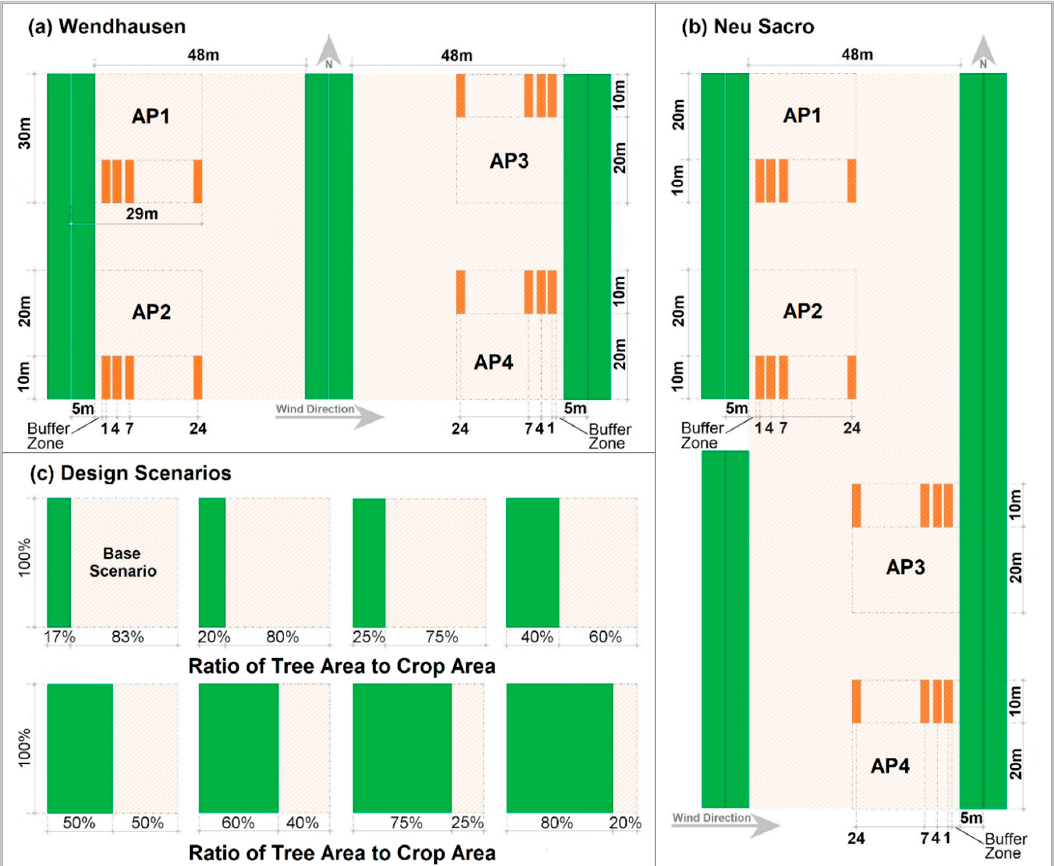
Figure A2. To-scale sketch of the 29 m × 30 m alley-cropping-plots (APs) design at Wendhausen ( a ) and Neu Sacro ( b ). At both sites, AP1 and AP2 are arranged leeward and AP3 and AP4 windward. The solid-coloured areas correspond to the tree strips and the shaded areas to the cropped surfaces. The orange bars represent the 2 m × 10 harvest transects located 1 m, 4 m, 7 m, and 24 m away from the tree strips. As the experimental part of this study focused on a ratio of tree area to crop area of 17:82, the simulations considered design scenarios with ratios of tree area to crop area of 20:80, 25:75, 40:60, 50:50, 60:40, 75:26, and 80:20 ( c ).